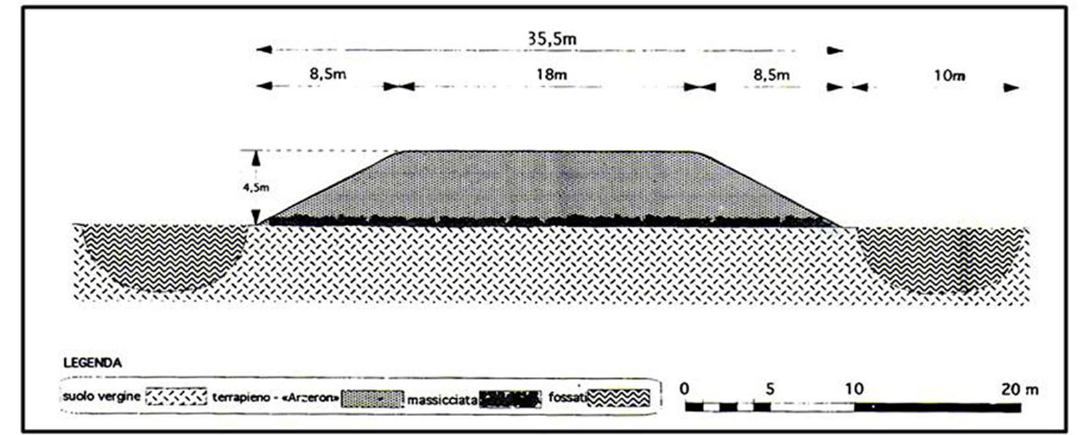
Fig. 6 The embankment of the road from Patavium to the Asiago plateau (from Bonetto